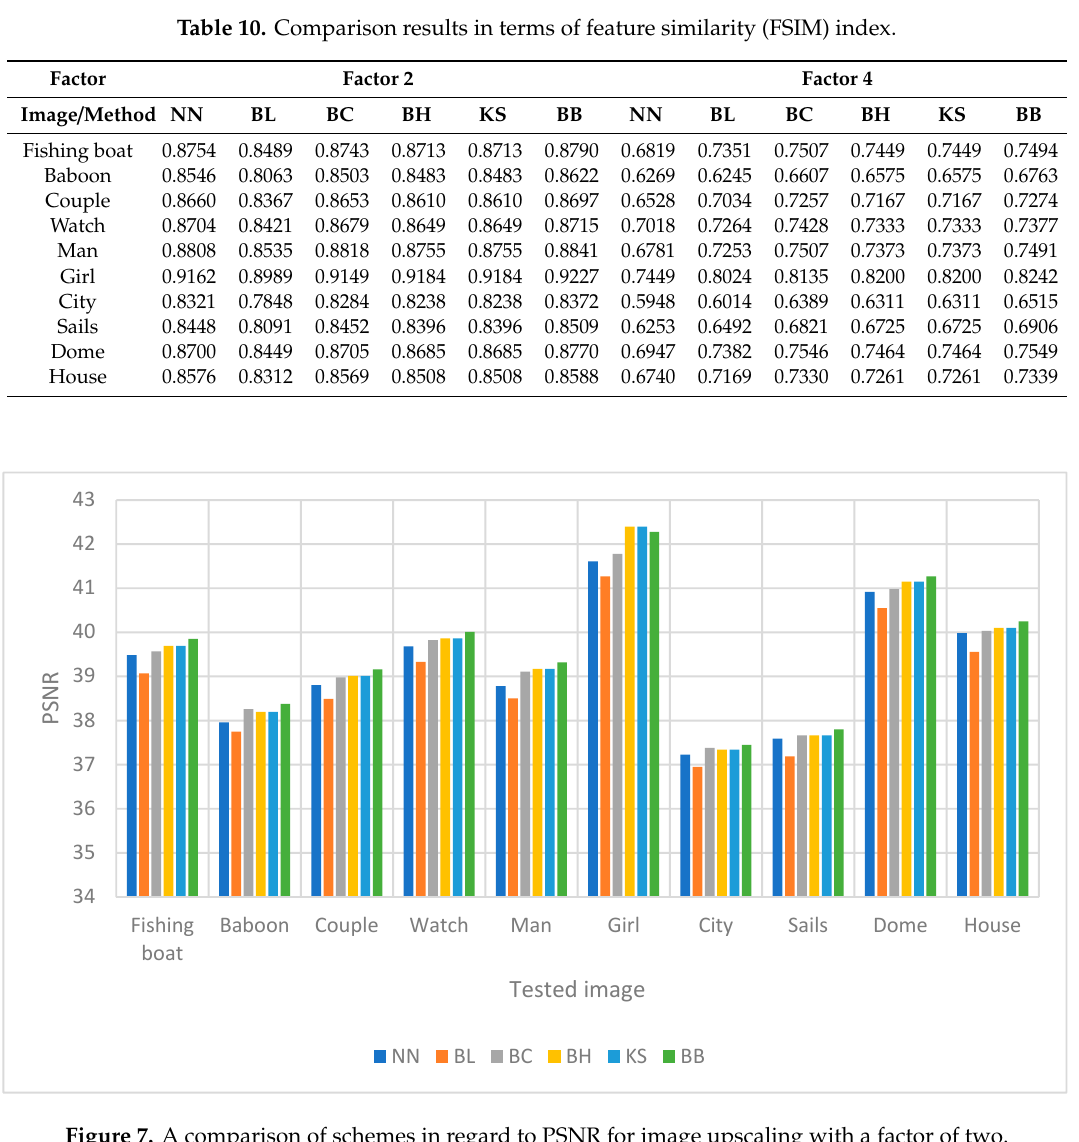
Figure 8. A comparison of schemes in regard to PSNR for image upscaling with a factor of four.